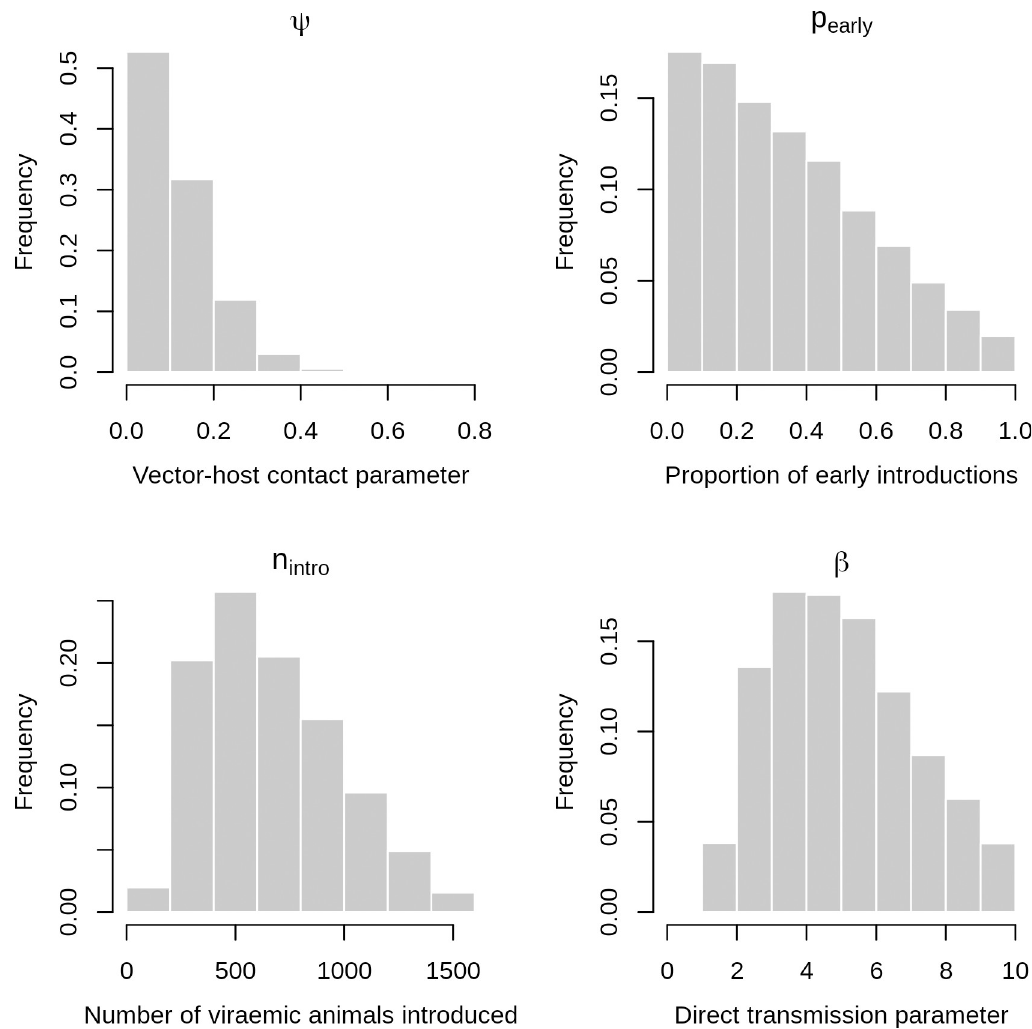
Fig 4. Posterior distributions of estimated parameters. Model is M4 which combines direct transmission between hosts but no VT in Aedes , and repeated introductions of RVFV by viraemic nomadic animals, each rainy season, from 2008 to 2015. ψ : scaling factor for vector population sizes, β : direct transmission parameter between hosts, n intro : total number of viraemic nomadic animals introduced during a rainy season, p : proportion of those animals arriving during the 1 st half of the rainy intro season, p early : proportion of viraemic nomadic ruminants arriving during the 1st half of the rainy season.